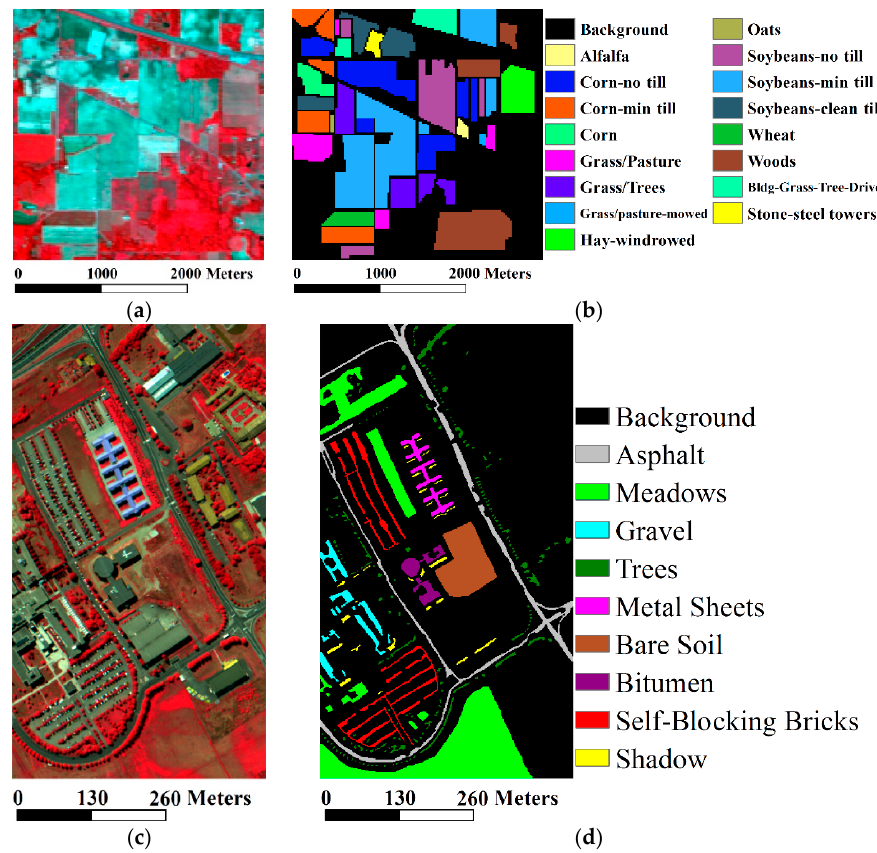
Figure 3. Hyperspectral images and the corresponding ground truth data (GTD). ( a ) A false color composite image (bands 47, 23, and 13) of the Indian Pines (IP) image and ( b ) its GTD; ( c ) a false color composite image (bands 103, 56, and 31) of the University of Pavia (UP) image and ( d ) its GTD.